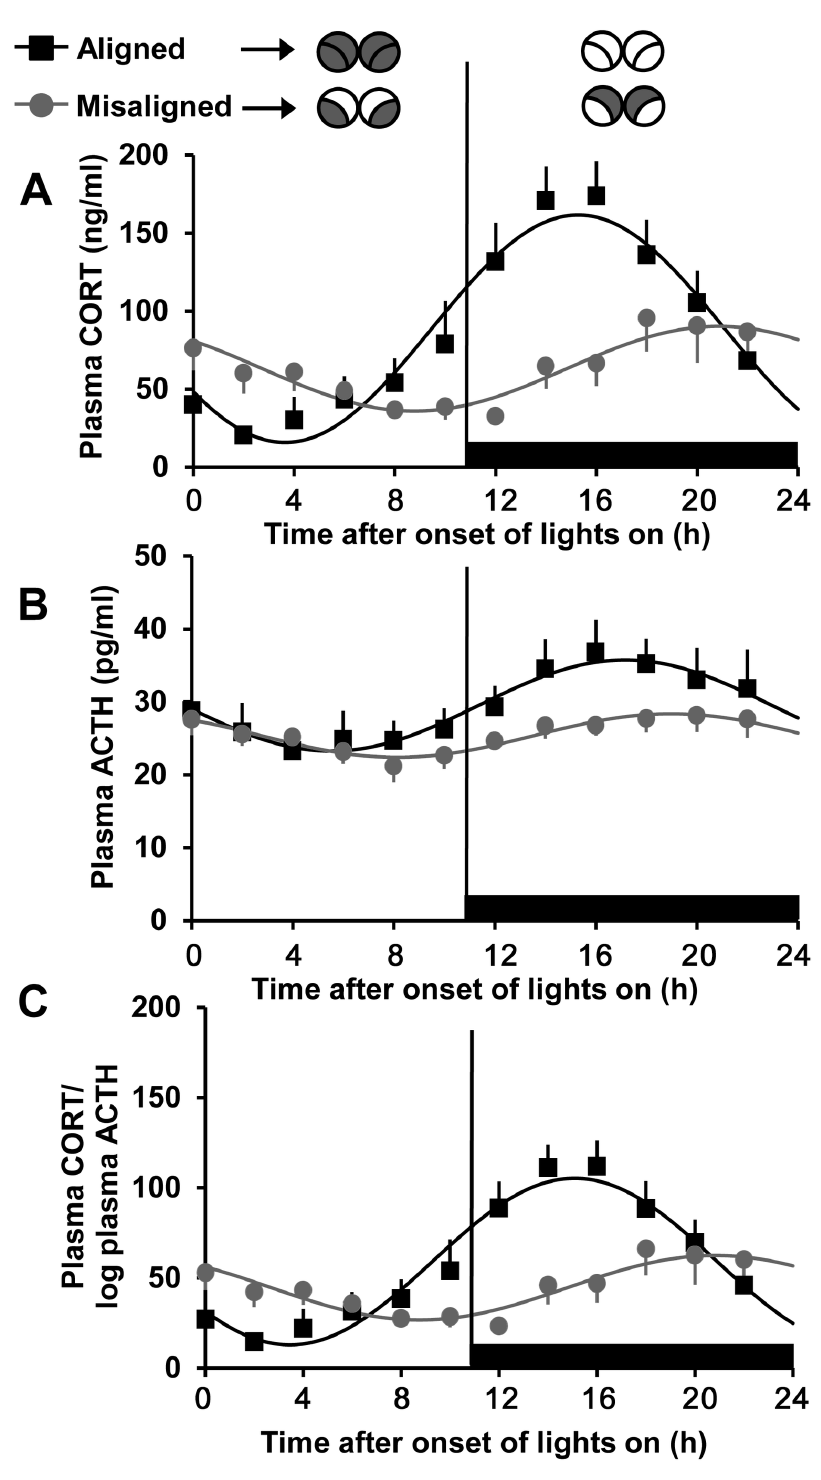
Figure 2. The plasma corticosterone rhythm is disrupted on days of misalignment. Plasma corticosterone (A), ACTH (B) and corticosterone/log ACTH (C) on aligned ( black ) and misaligned ( grey ) days. Black horizontal bars denote times when lights are off. Illustrations ( top ), as in Figure 1E, show predicted Per1 expression patterns in the subregions of the SCN at the midpoint of the lights-on and lights-off on days of alignment and misalignment. Data are means ± SEM and fitted with a sine wave function (see materials and methods). n = 5; the same animals make up both aligned and misaligned groups. doi: 10.1371/journal.pone.0068793.g002 PLOS ONE |